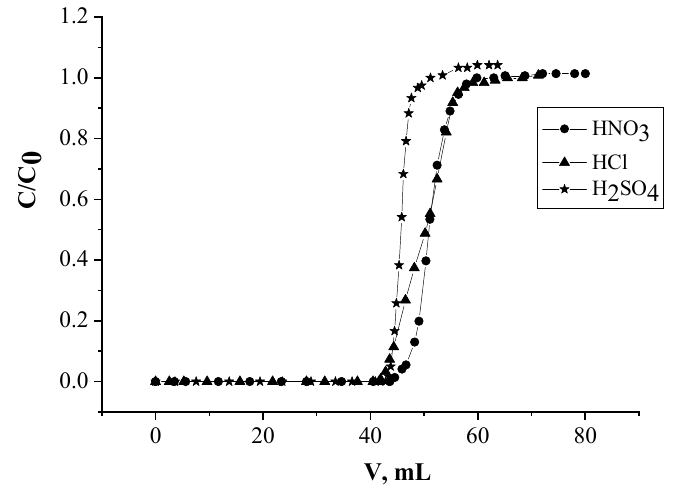
Figure 5. The influence of acid nature on Nd(III) adsorption recovery.